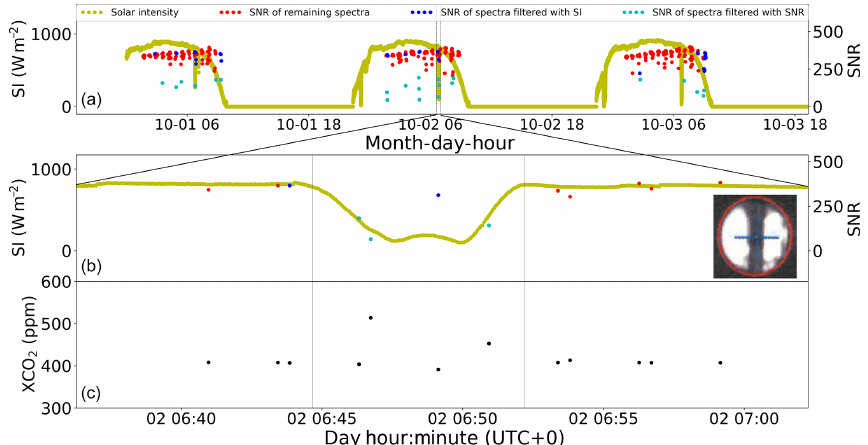
Figure 5. The direct solar intensity from 1 to 3 October 2018, with a zoom of the time period between 06:36 and 07:02 (UTC) on 2 Octo- ber 2018 when the tower shadow is observed by the FTIR instrument (see the inside camera image, b ). The blue dots (a) denote the SNR of spectra filtered with solar intensity (SI), the cyan dots denote the SNR of spectra filtered with SNR and the red dots denote the SNR of spectra after both filters. The XCO 2 retrievals during the time with the shadow are displayed in (c) .